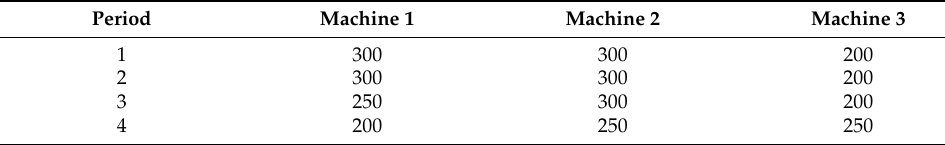
Table 6. Upper Bound for Additional Resources.